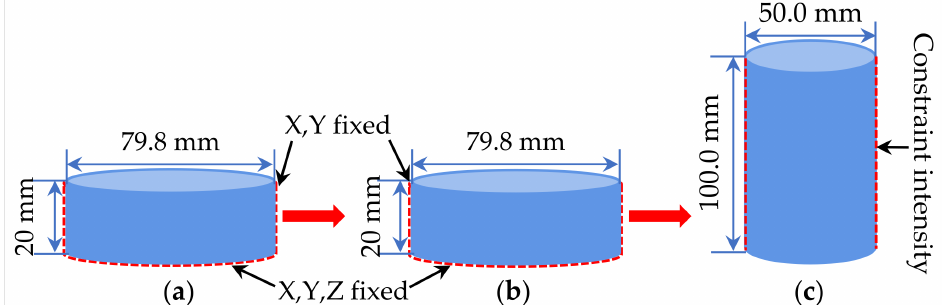
Figure 4. Process of aeolian sand experiment; ( a ) Physical consolidation test; ( b ) Numerical simulation of consolidation test; ( c ) Numerical simulation experiment of sand-gabion.